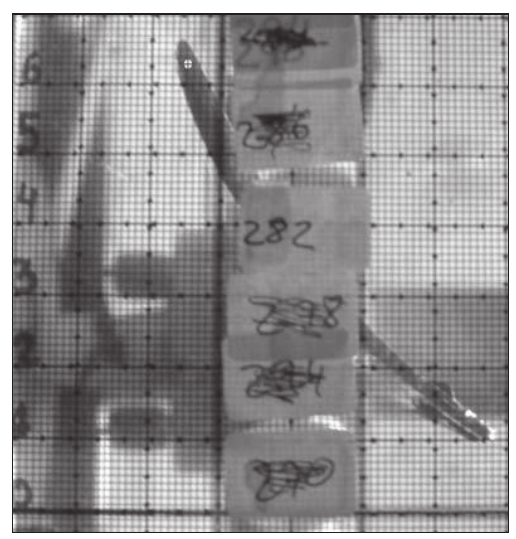
Figure 12: Typical visualization photo (digitally